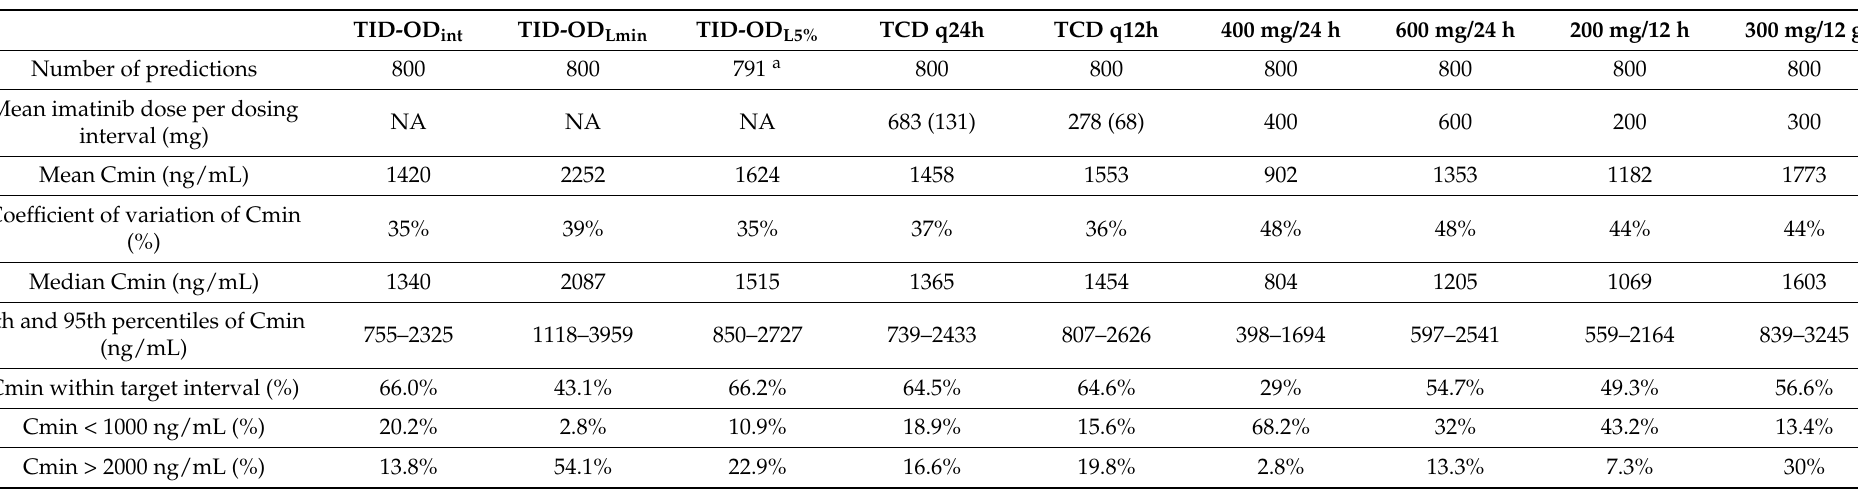
Table 1. Imatinib Cmin and attainment of target interval (1000–2000 ng/mL) for the various dosing methods in all simulated